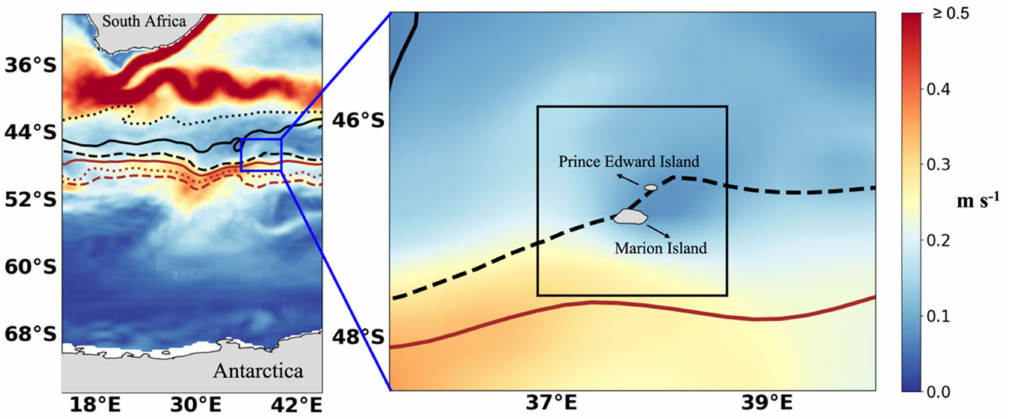
Figure 1. Long-term mean surface geostrophic current speed (m s − 1 ) between South Africa and Antarctica showing the position of the Prince Edward Islands. The northern, middle, and southern branches of the sub-Antarctic Front are shown as black dotted (N-SAF), solid (M-SAF) and dashed (S-SAF) lines, respectively. The northern, middle, and southern branches of the Antarctic Polar Front are shown as brown solid (N-APF), dotted (M-APF), and dashed (S-APF) lines, respectively. The black box indicates the 2 ◦ × 2 ◦ area over which data were averaged to determine long-term trends and interannual